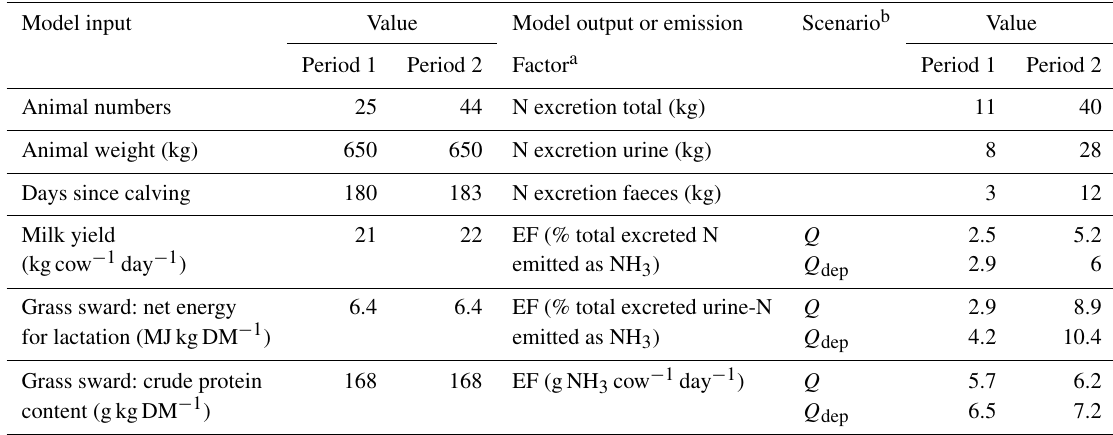
Table 3. N excretion model inputs, results, and derived emission factors. Model